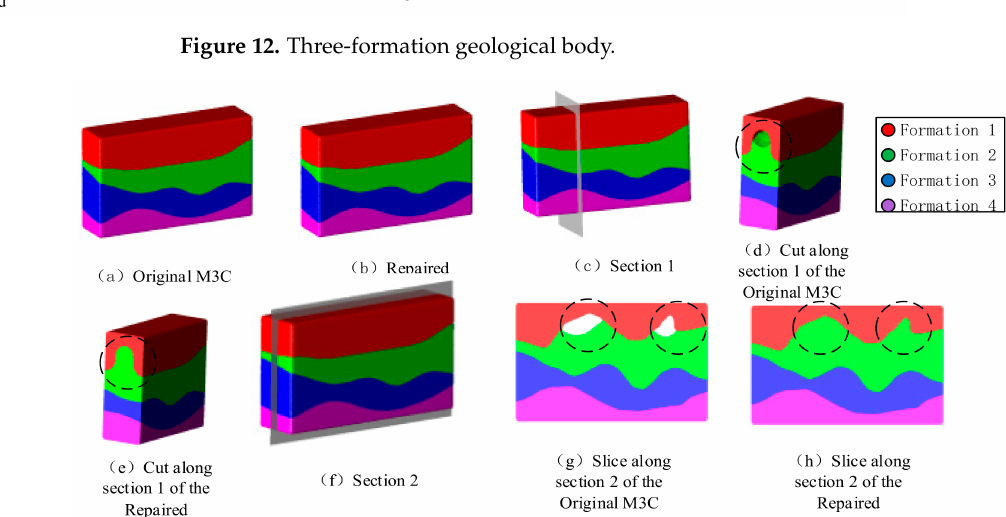
Figure 13. Four-formation geological